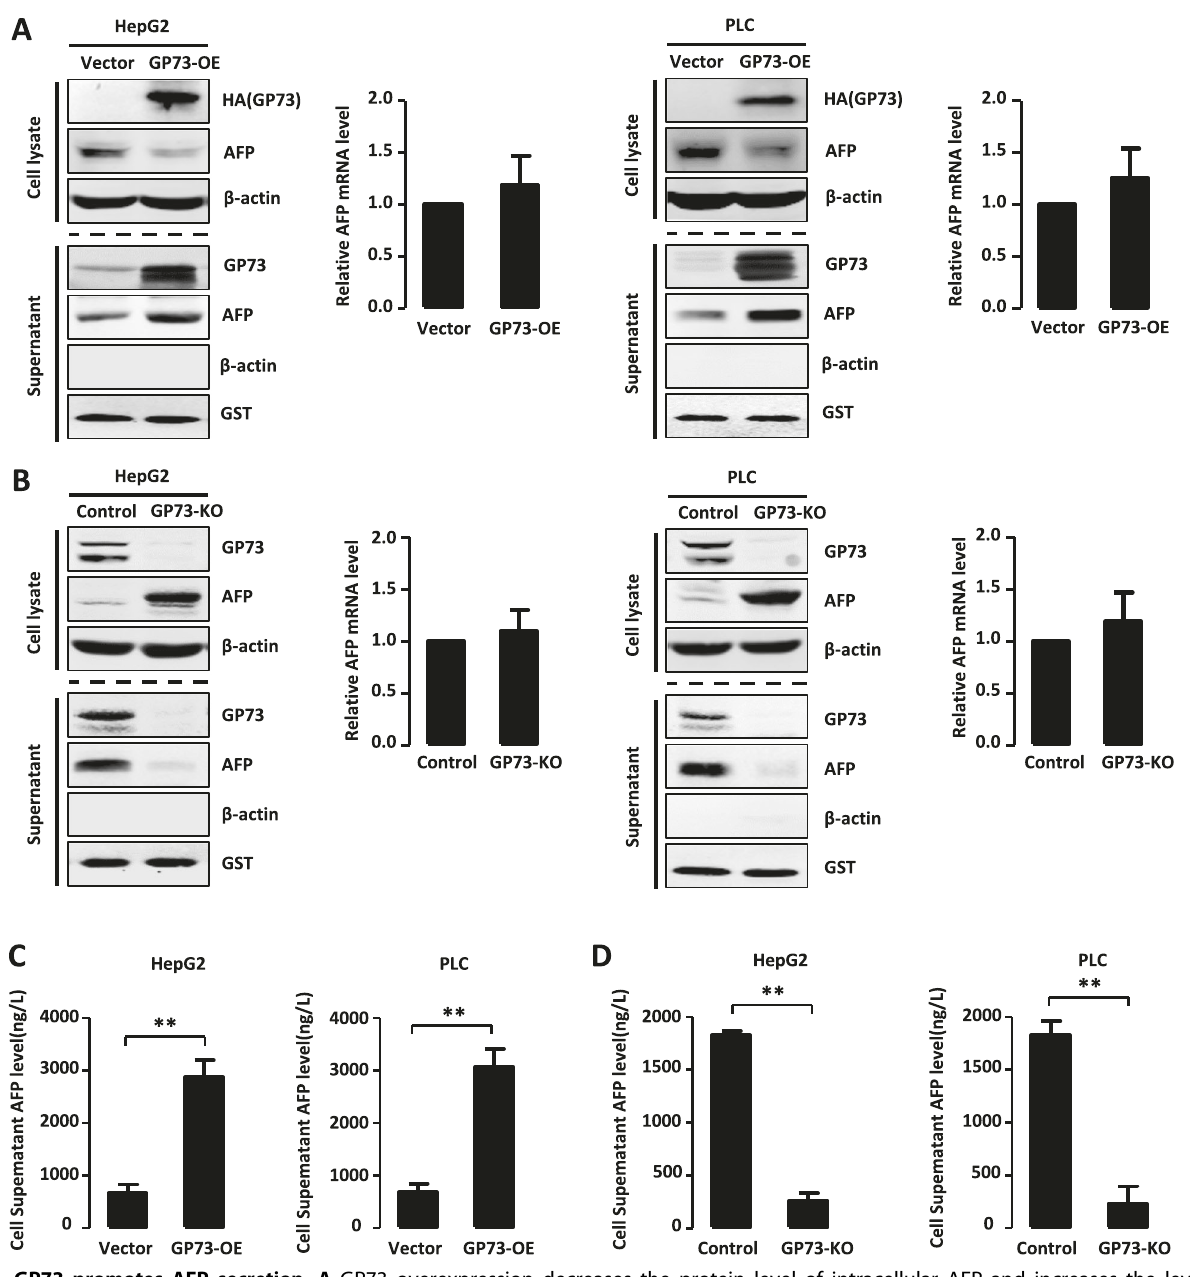
Fig. 1 GP73 promotes AFP secretion. A GP73 overexpression decreases the protein level of intracellular AFP and increases the level of extracellular AFP. The protein levels of GP73 and AFP in cell lysate and supernatant were measured by western blotting in HepG2 and PLC cells transfected with PCDNA3-GP73 or PCDNA3 (as a control). β -actin or GST was respectively used as an intracellular or extracellular loading control. The mRNA level of AFP in cell lysate was measured by Real-time PCR. B GP73 knockout increases the protein level of intracellular AFP and decreases the level of extracellular AFP. The protein levels of GP73 and AFP in cell lysate and supernatant were measured by western blotting in HepG2 and PLC cells mediated GP73 knockout by CRISPR/Cas9 system. β -actin or GST was respectively used as an intracellular or extracellular loading control. The mRNA level of AFP in cell lysate was measured by Real-time PCR. C GP73 overexpression increases the secretion level of AFP. Stable transfected HepG2 and PLC cells overexpressed GP73. Cell culture supernatant was collected and AFP level was measured by ELISA. D GP73 knockout decreases the secretion level of AFP. The expression of GP73 in HepG2 and PLC cells were knockout by CRISPR/Cas9 system. Cell culture supernatant was collected and AFP level was measured by ELISA. Error bars represent S.D. * p < 0.05, ** p <